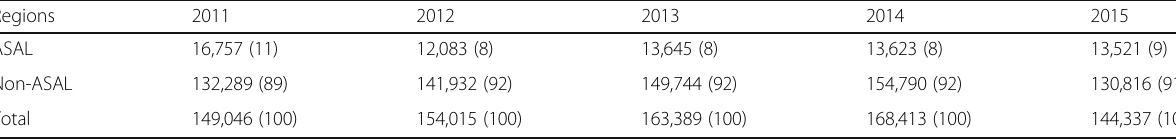
Table 9 Contribution of ASAL fish to the national fish production in metric tonnes